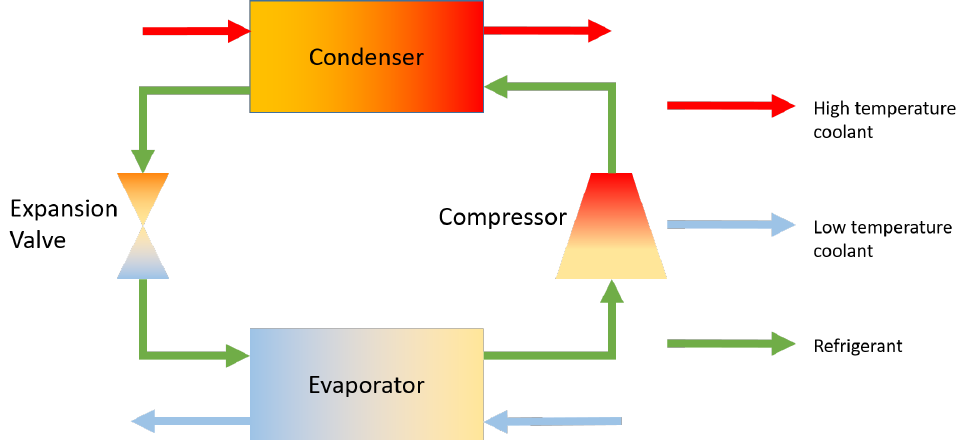
Figure 6. The refrigeration cycle is physically modelled. At this level, the speed of the compressor is controlled either by the demand from the heat pump controller, or a PID which stops the system pressure getting too